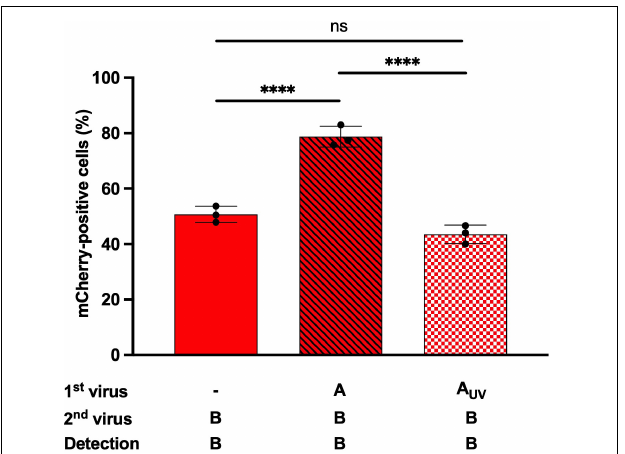
FIGURE 5 | Effect of UV-inactivated IAV on IBV infection. A549 cells were infected for 1 h with IAV-GFP or an UV-inactivated IAV-GFP (IAV-GFP-UV) and then with IBV-mCherry for 6 h and analyzed by flow cytometry. The solid bar represents the proportion of mCherry-positive fluorescent cells upon control infection with IBV-mCherry alone. The hatched bar represents the proportion of mCherry-positive cells upon co-infections. The squared bar represents the proportion of mCherry-positive cells upon co-infection with IAV-GFP-UV and IBV-mCherry. One experiment representative of two independent experiments performed in triplicate is shown (see Supplementary Figure S3 ). The mean ± S.D. of biological triplicate is shown. Two-way ANOVA test: